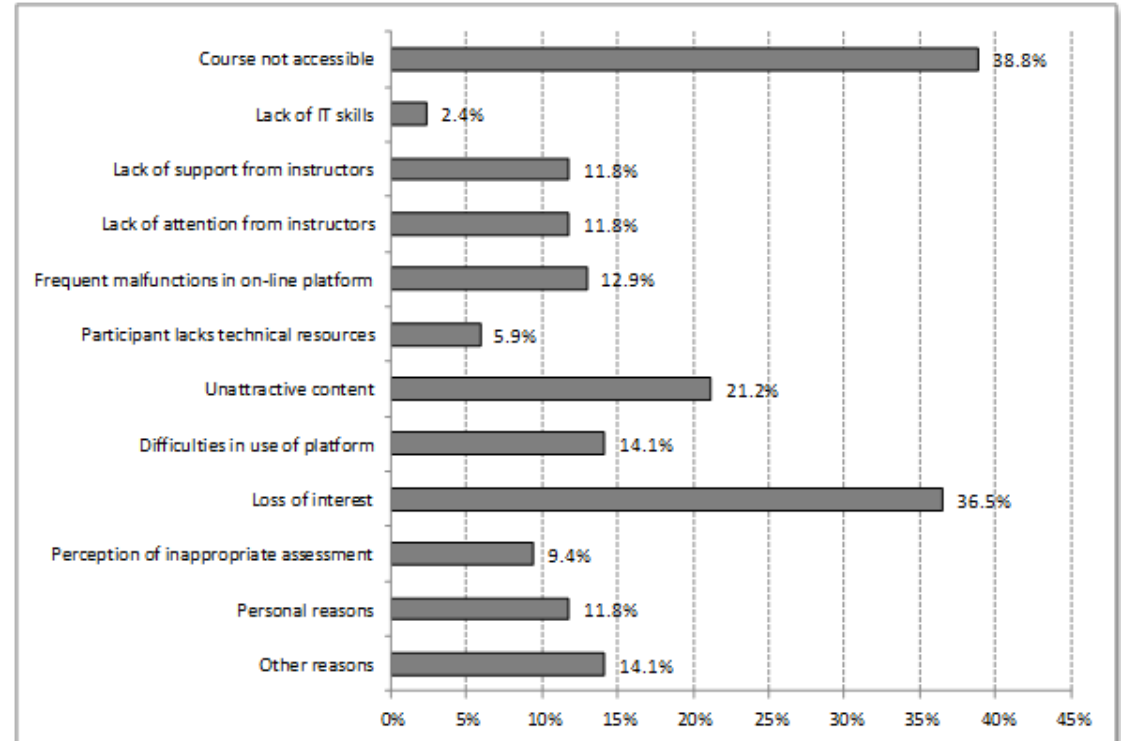
Figure 16. Reasons alleged by deaf and hard of hearing participants to drop out of an on-line course at some time by reason for giving up (relative data). Multiple answers possible. Valid answers: 85. Levels of drop-out and satisfaction with the e-learning experience were analysed to determine whether there were relationships with the following social and demographic characteristics: sex, age, degree of deafness, age of onset of deafness, language of communication, size of habitat, level of education, employment situation, and net monthly household income (Table 4). Significant relationships were found between: Level of education (X11) and levels of drop-out (X20). Level of education (X11) and overall satisfaction with the experience (X22). Net monthly household income (X13) and overall satisfaction with the experience